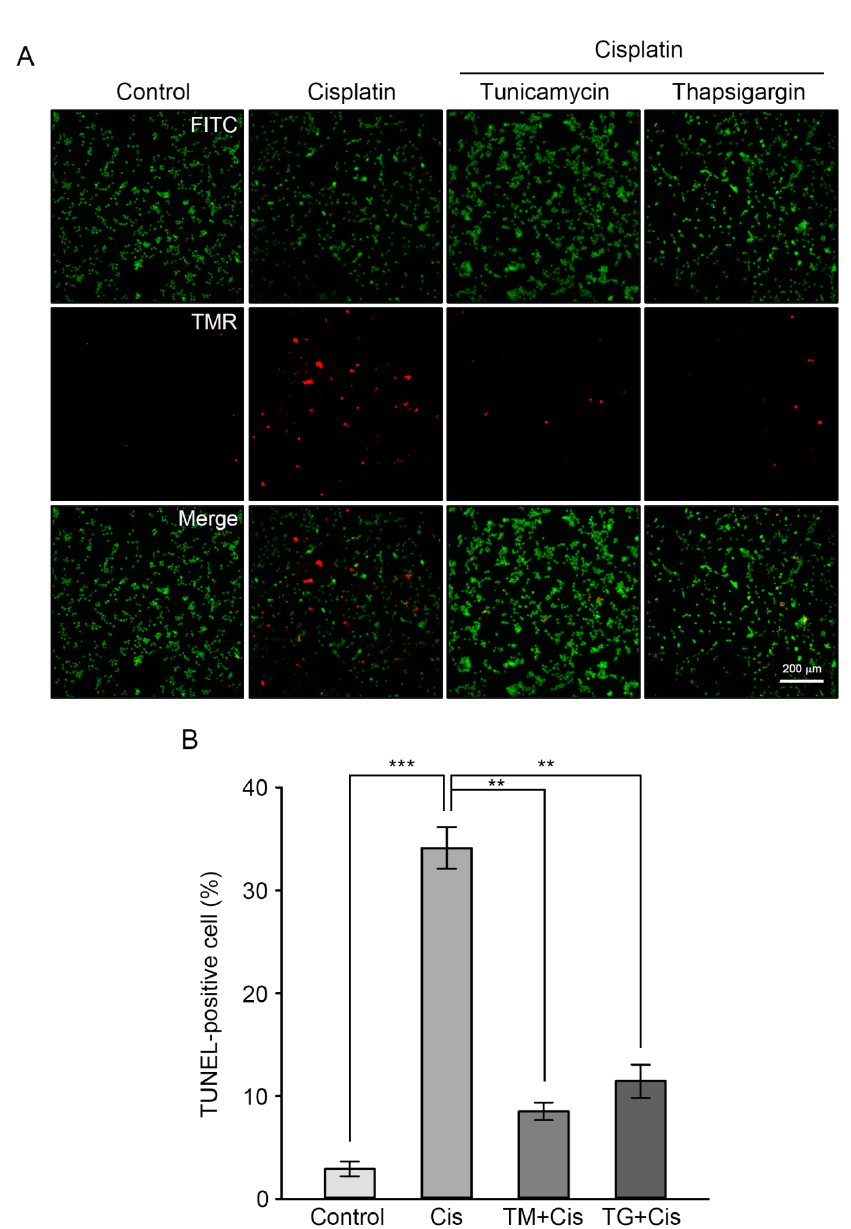
Figure 4. Attenuation of cisplatin-mediated apoptosis through GRP78 and GRP94 overexpression. Cells were treated with TM or TG and then cisplatin, as previously described. ( A ) Fluorescence images with calcein AM were examined to detect “live” cells (FITC; green) and “apoptotic” cells (TMR; red). Scale bars = 200 µ m. Original magnification, 40 × . ( B ) The percentage of TUNEL-positive cells as shown in ( A ) was determined from ≈ 1000 cells that spanned 3–4 microscopic fields. Values are expressed as means ± SE. ** p < 0.01, compared with cisplatin-treated cells; *** p < 0.001, compared with the untreated